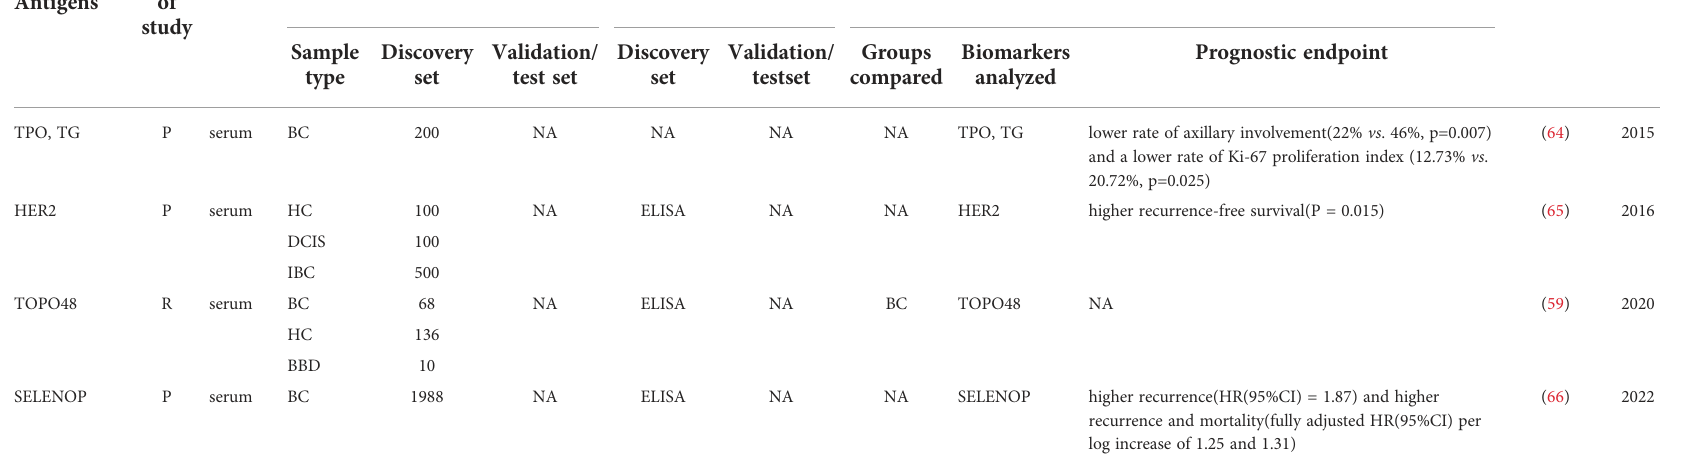
AUC, area under the curve; R, retrospective study; P, prospective study; NA, not available; ELISA, enzyme-linked immunosorbent assay; SEREX, serological analysis of recombinant cDNA expression libraries; SERPA, serological proteome analysis; WB, Western blot; BC, patients with breast cancer; HC, healthy controls; BBD, patients with benign breast disease; DCIS, ductal carcinoma in situ; ONBC, patients with other nonbreast cancers; RA, patients with rheumatoid arthritis; HRNBC, hormone receptor-negative; ER +/PR+BC, breast cancerpatients withestrogen receptor positive/progesterone receptor positive; BCSI & II, patients with breast cancer atstage I orII; BCS III & IV, patients with breast cancer atstage III orIV; BBT, patient withbenign breast tumor; BLBC, patients with basal-like breast cancer; T1N0PBC, patients with primary breast cancer without lymph node metastasis at early stage; IBC, invasive breast cancer; LCIS, lobular carcinoma in situ; SLE, patients with systemic lupus